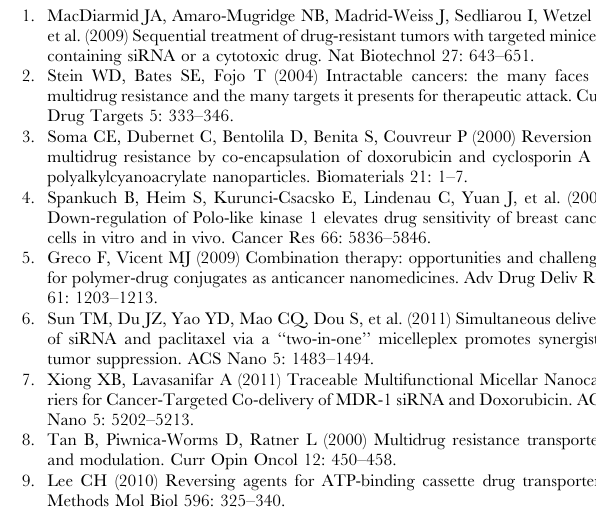
Figure S1 FT-IR spectra of GO, PSS, PEI and PPG. (TIF) Figure S2 Characterization of PPG by 1 H and 13 C MAS NMR spectra. Liquid-state 1 H MAS NMR spectra of GO (A), PSS (B), PEI (C) and PPG (D), Liquid-state 13 C MAS NMR